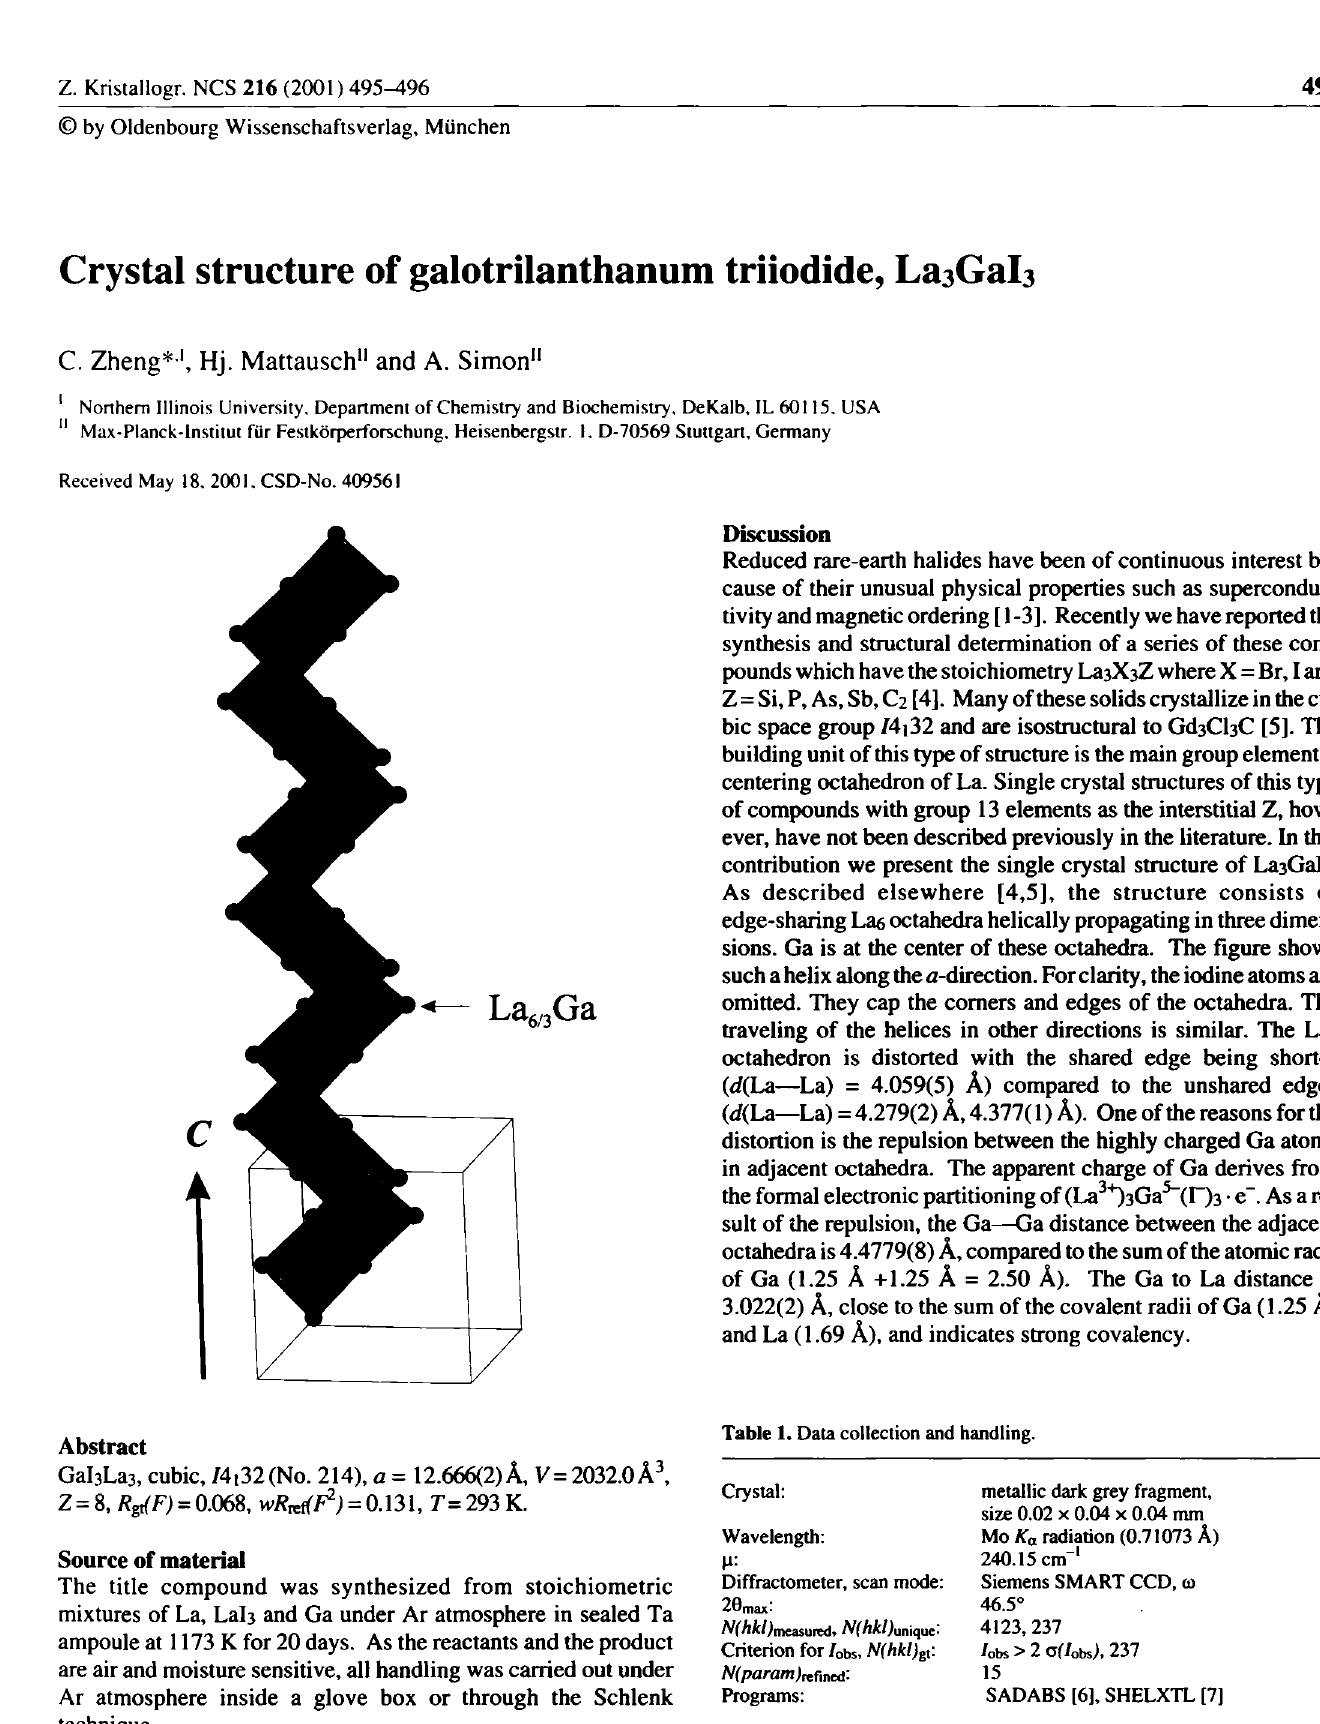
Table 1. Data collection and